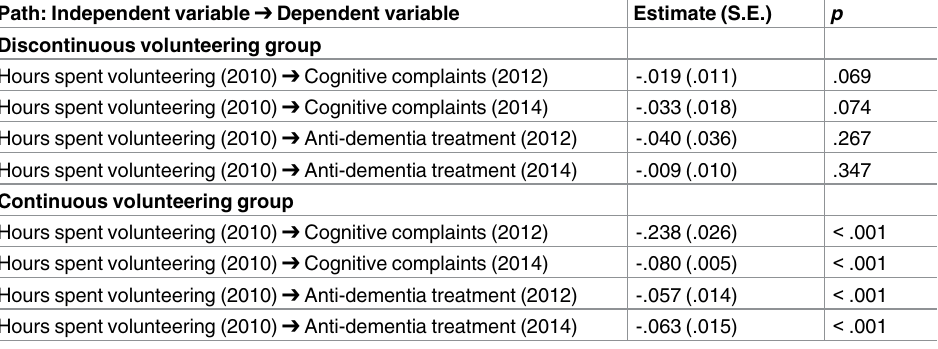
Table 2. Standardized coefficients of the normal causation path model: Paths from hours of voluntary work (2010) to cognitive complaints and anti-dementia treatment (2012 & 2014). Path: Independent variable ➔ Dependent